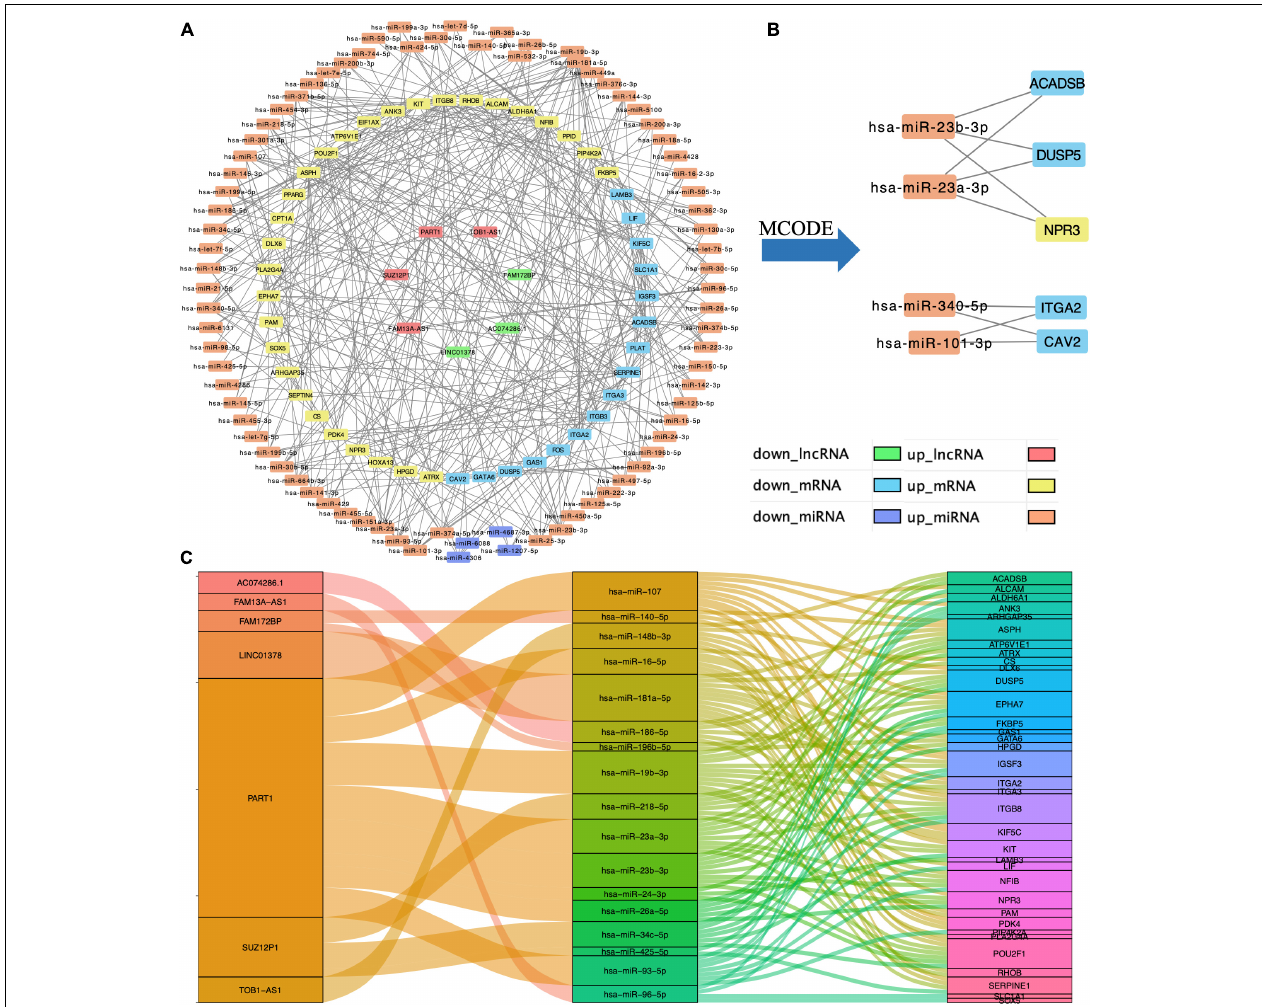
FIGURE 3 | Construction of lncRNA–miRNA–mRNA regulatory network. (A) The lncRNA–miRNA–mRNA regulatory network. (B) The key module network selected from lncRNA–miRNA–mRNA regulatory network. (C) The connection between lncRNAs, miRNAs, and mRNAs.